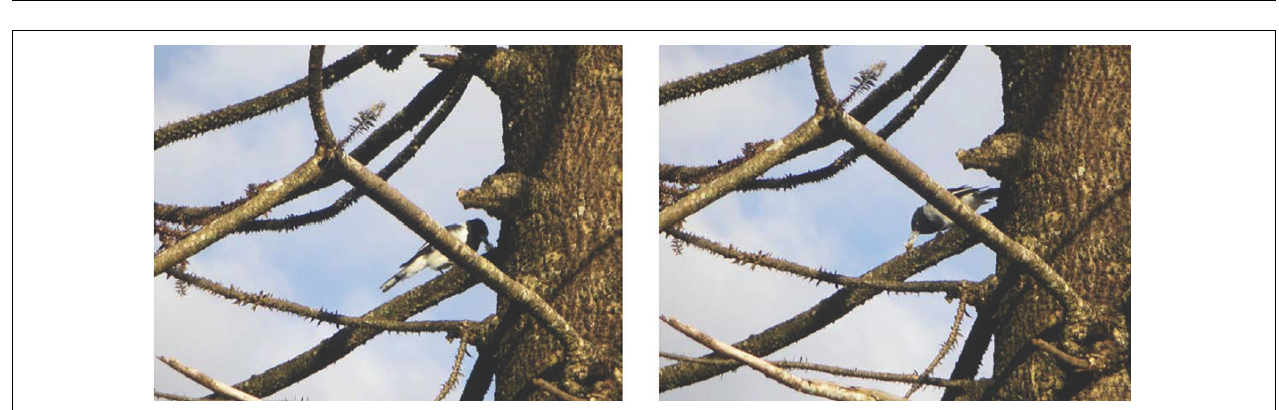
FIGURE 6 | An adult pied butcherbird removes a morsel of cached chicken from their